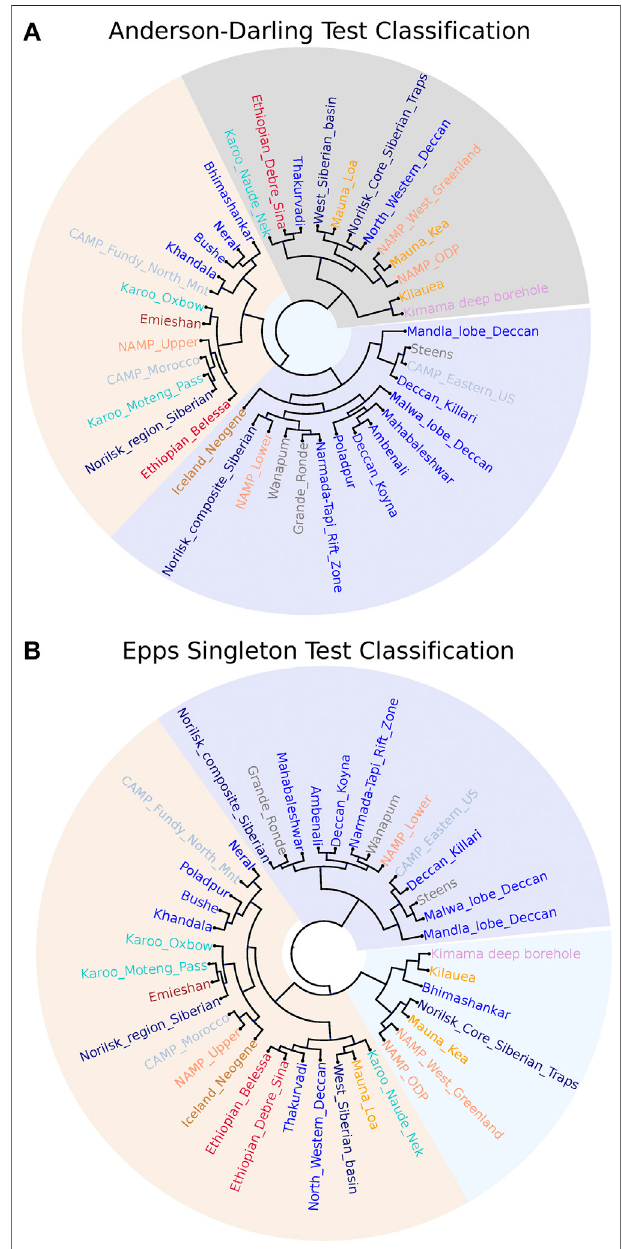
FIGURE 12 | (A) Clustering of fl ow lobe thickness distributions using distance metric based on Anderson-Darling statistical tests. CFB provinces are color-coded so that formations of a CFB Province have the same color (same colors as Figure 11 ). CFB Provinces are clustered into three distinct sub-groups highlighting classes of PDFs. (B) Clustering of fl ow lobe thickness distributions using distance metric based on Epps Singleton statistical tests. CFB provinces are color-coded so that formations of a CFB province have the same color (same colors as Figure 11 ). CFB provinces are clustered into three distinct sub-groups highlighting classes of